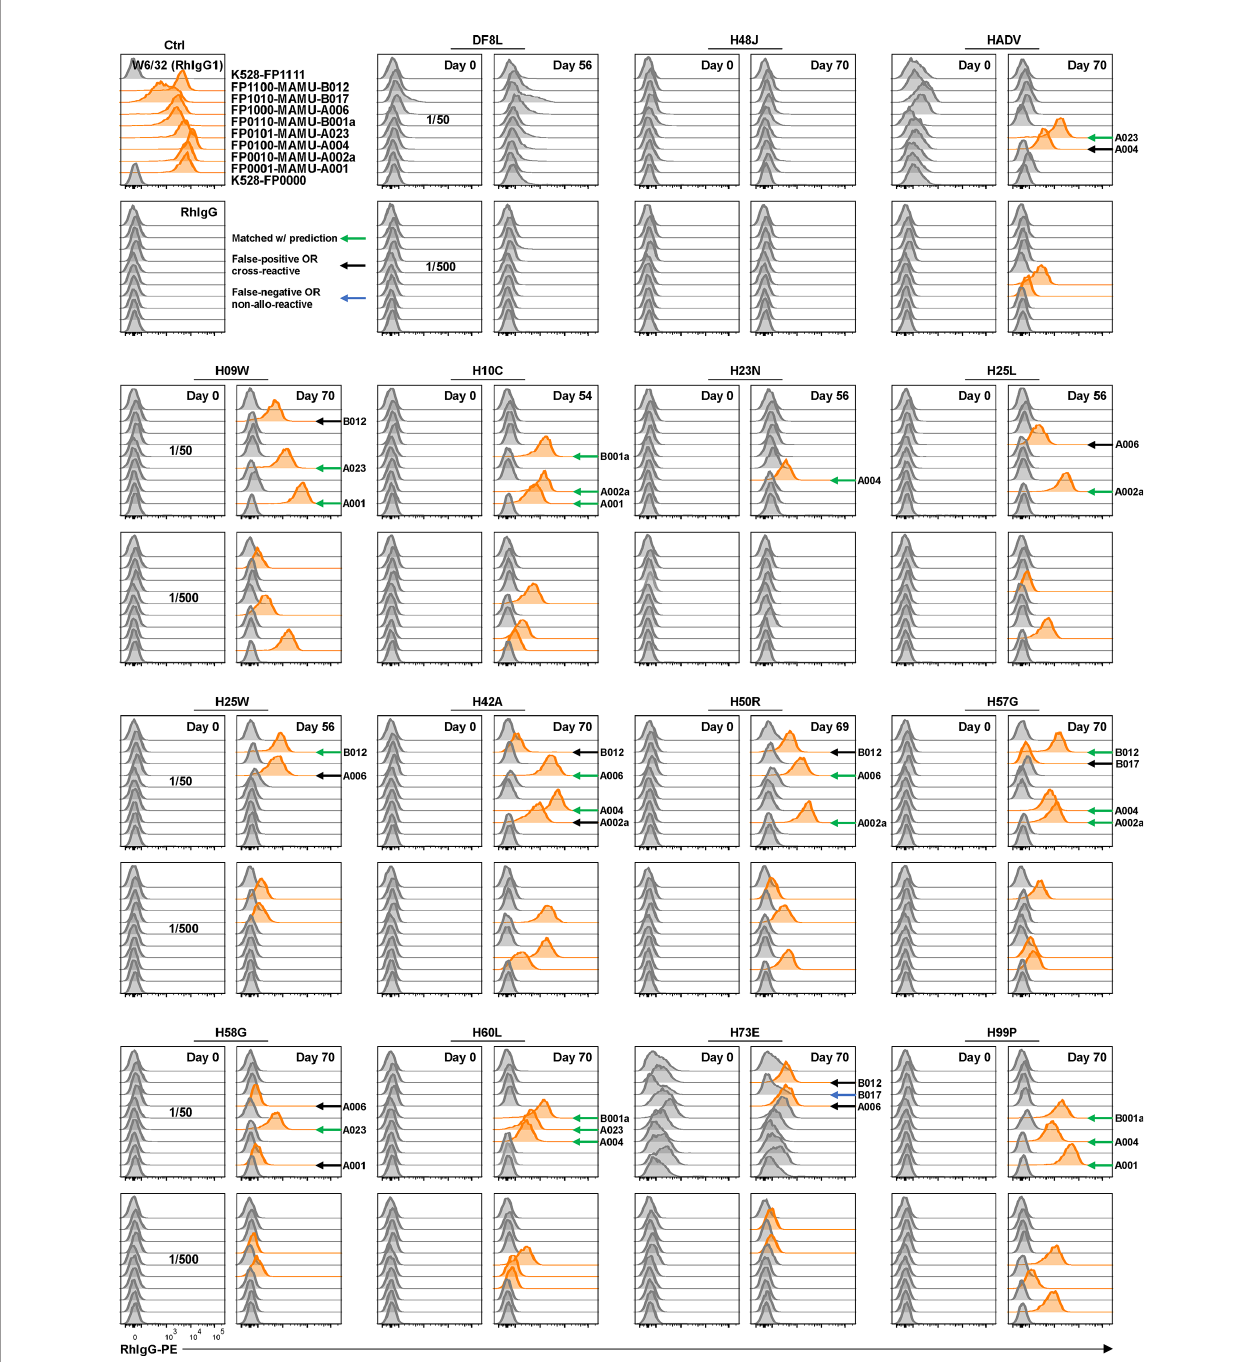
FIGURE 3 | Application of reporter cell line assay in multiplex detection of anti-Mamu antibodies in serum samples from allo-sensitized RMs. K528-derived fl uorescence-barcoded reporter cell lines were transduced to express Mamu class I molecules along with rhesus b 2M. The resultant monoclonal cell lines were pooled, stained with sera from 15 allo-sensitized RMs at dilutions 1/50 and 1/500. W6/32 (RhIgG1) was used as positive control, and normal rhesus serum IgG (RhIgG) as negative control in staining. Demultiplexed reporter cell lines with MFI values above three-fold of the average MFI value of internal control cell lines (K528- FP0000 and K528-FP1111) were scored as positive and the histograms were highlighted in orange. The speci fi cities were predicted based on donor Mamu haplotypes that mismatch with host ones. Positive readouts matched with prediction were indicated with green arrows. Positive readouts beyond prediction were either false positive detections or due to cross-reactivity and were indicated with black arrows. Predicted but undetected speci fi cities were either false negative detections or due to non-allo-reactivity of the donor Mamu molecules in the corresponding host, and were indicated with blue arrows. B012 stands for B012a or